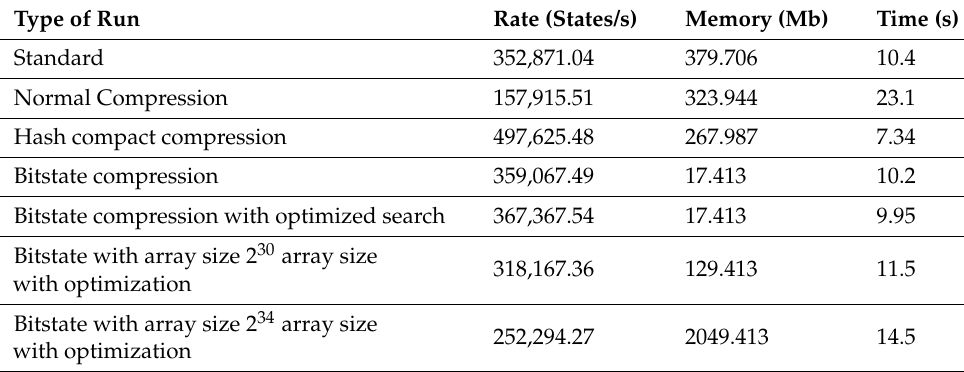
Table 4. Compression effect on the simulation results.